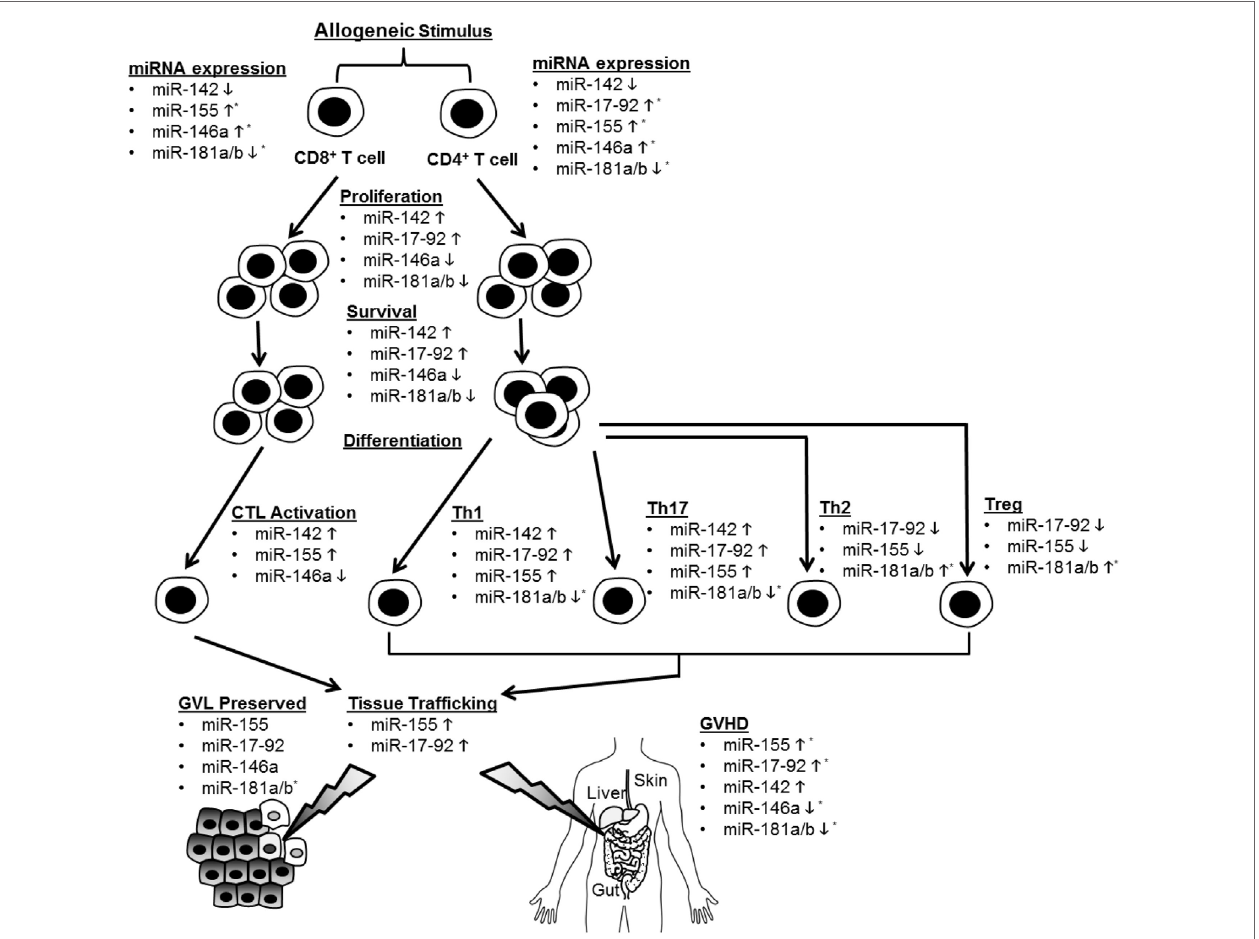
FiGURe 1 | Summary of microRNA (miRNA)-mediated modulation of allogeneic T cell function. CD4 + and CD8 + T cells are depicted undergoing proliferation, survival, differentiation, tissue trafficking, and effector functions [graft-versus-leukemia/tumor (GVL) and graft-versus-host disease (GVHD)] following an allogeneic stimulus. miRNA expression in T cells is depicted as increased (5) or decreased (5) following allo-stimulation. The effect of individual miRNAs on the above aspects of allogeneic T cell biology is depicted as enhancing (5) or inhibitory (5). If an miRNA is not listed under a given allo-T cell function, its effect on this function was negligible or not tested. *Indicates that human data support this conclusion.